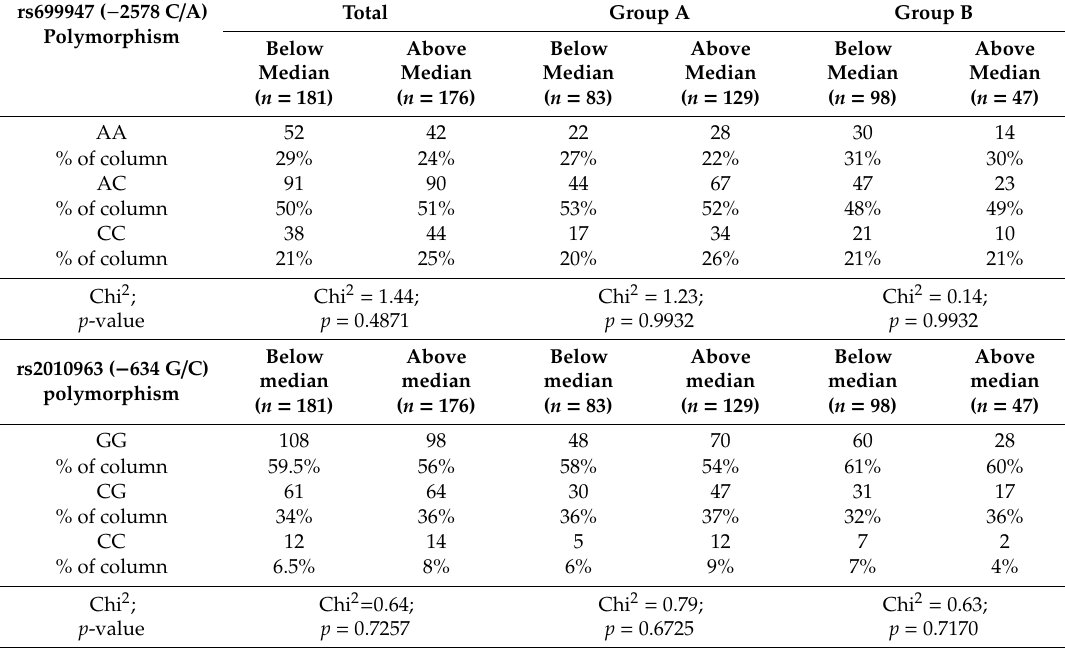
Table 7. Distribution of genotypes of rs699947 and rs2010963 variants of VEGF gene in relation to serum concentration of leptin below and above the